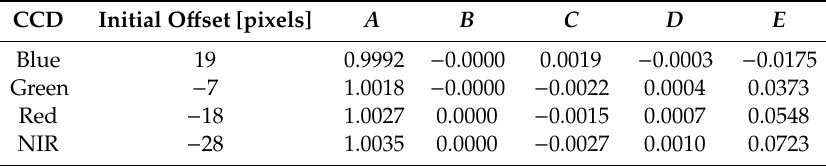
Table 3. Estimated parameters of the coordinate di ff erences due to the initial CCD o ff sets.